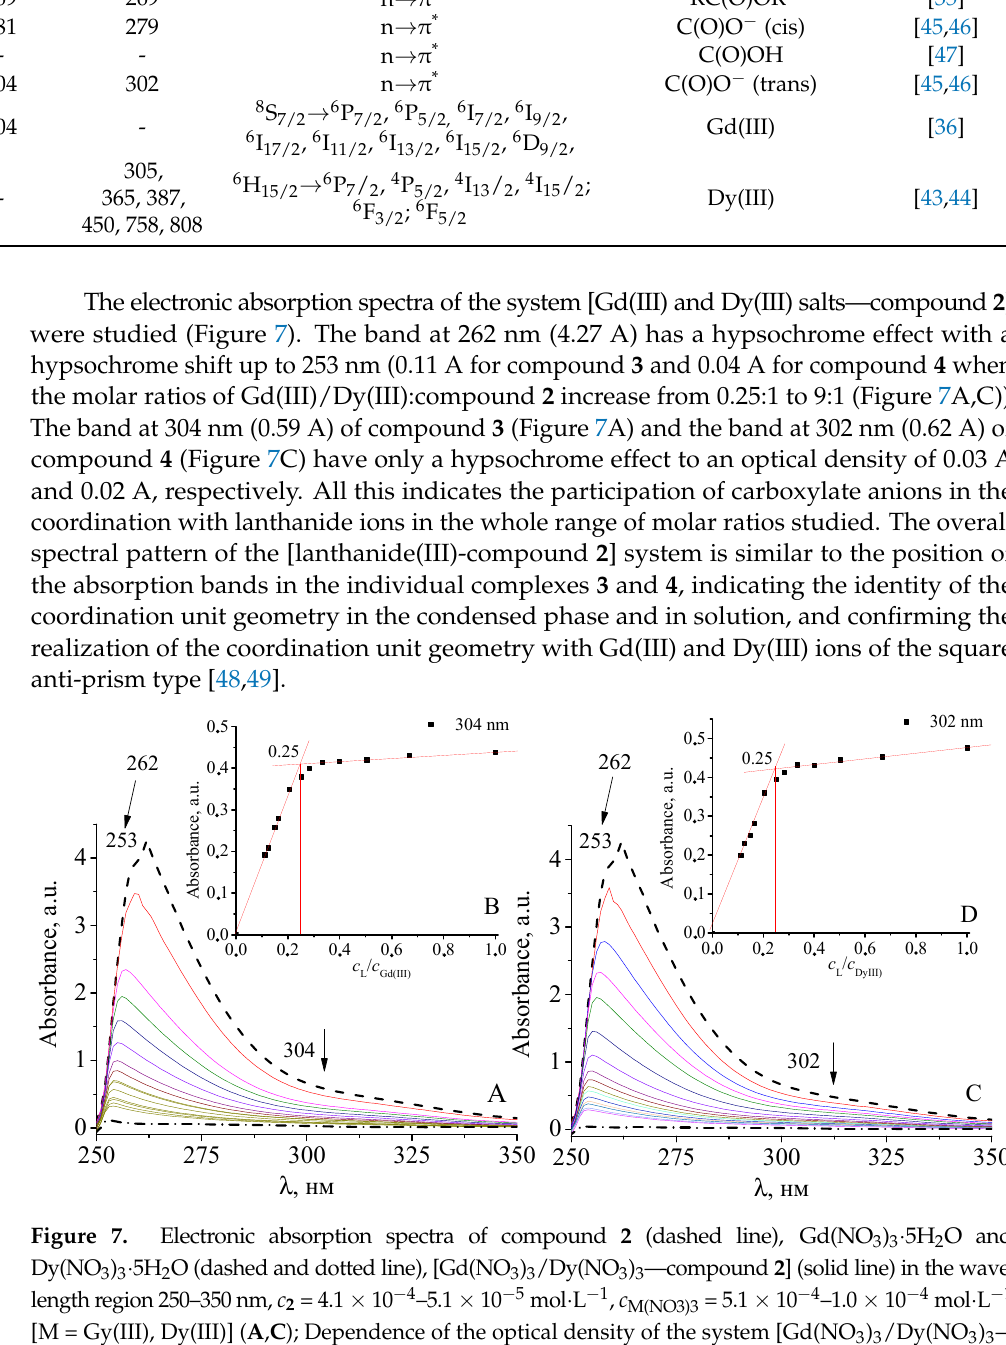
Figure 7. Electronic absorption spectra of compound 2 (dashed line), Gd(NO 3 ) 3 · 5H 2 O and Dy(NO 3 ) 3 · 5H 2 O (dashed and dotted line), [Gd(NO 3 ) 3 /Dy(NO 3 ) 3 —compound 2 ] (solid line) in the wave- length region 250–350 nm, c 2 = 4.1 × 10 − 4 –5.1 × 10 − 5 mol · L − 1 , c M(NO3)3 = 5.1 × 10 − 4 –1.0 × 10 − 4 mol · L − 1 [M = Gy(III), Dy(III)] ( A , C ); Dependence of the optical density of the system [Gd(NO 3 ) 3 /Dy(NO 3 ) 3 — combination 2] at λ = 304 and 302 nm in DMSO on the ratio c L / c Gd(III)/Dy(III) ( B , D